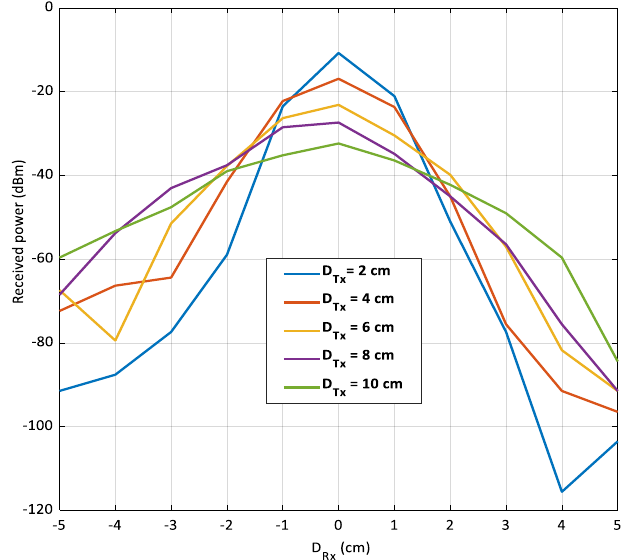
Figure 17. Stress test for Case B ( P in = 15 dBm, R L = 0.6 k Ω